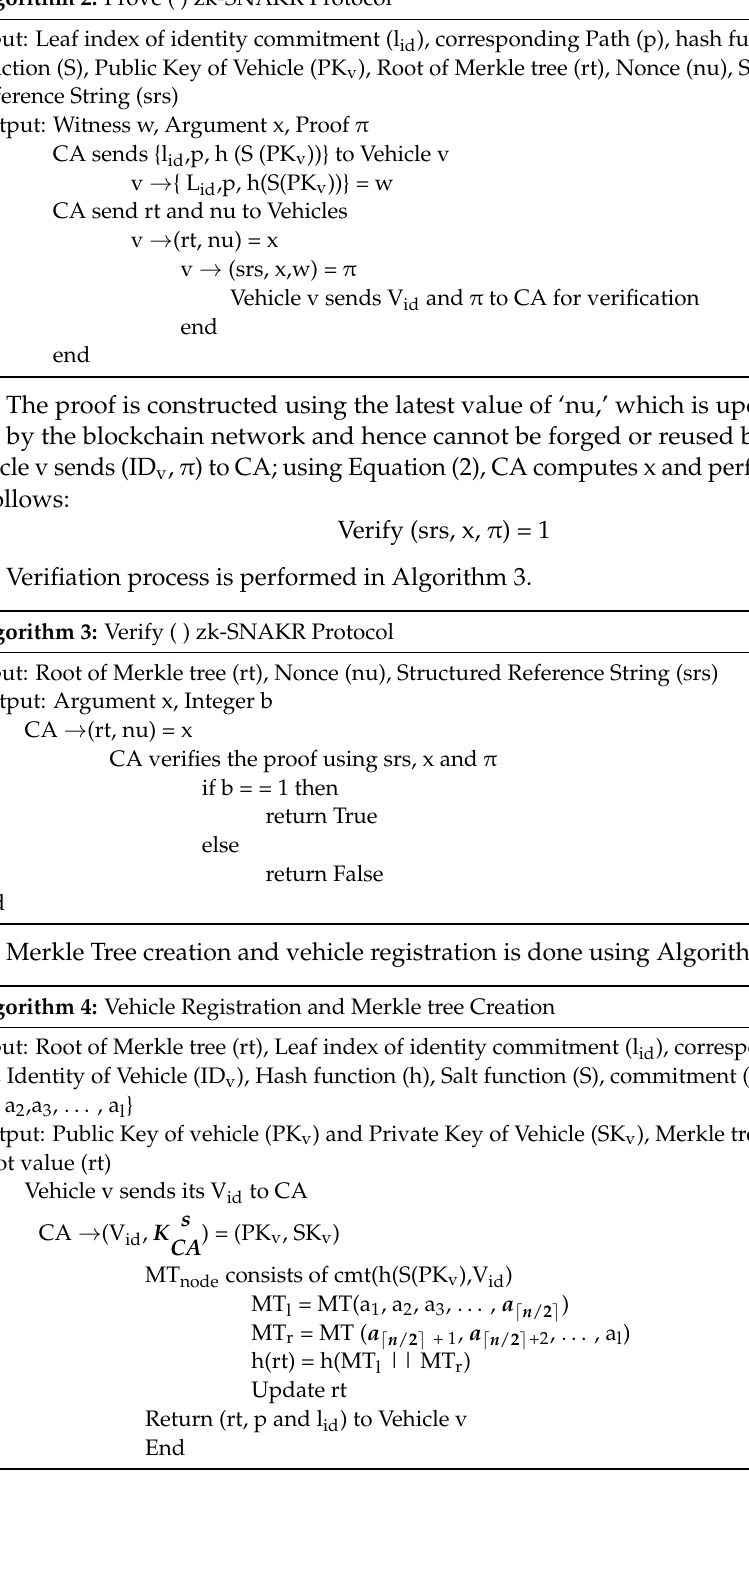
Algorithm 2: Prove ( ) zk-SNAKR Protocol